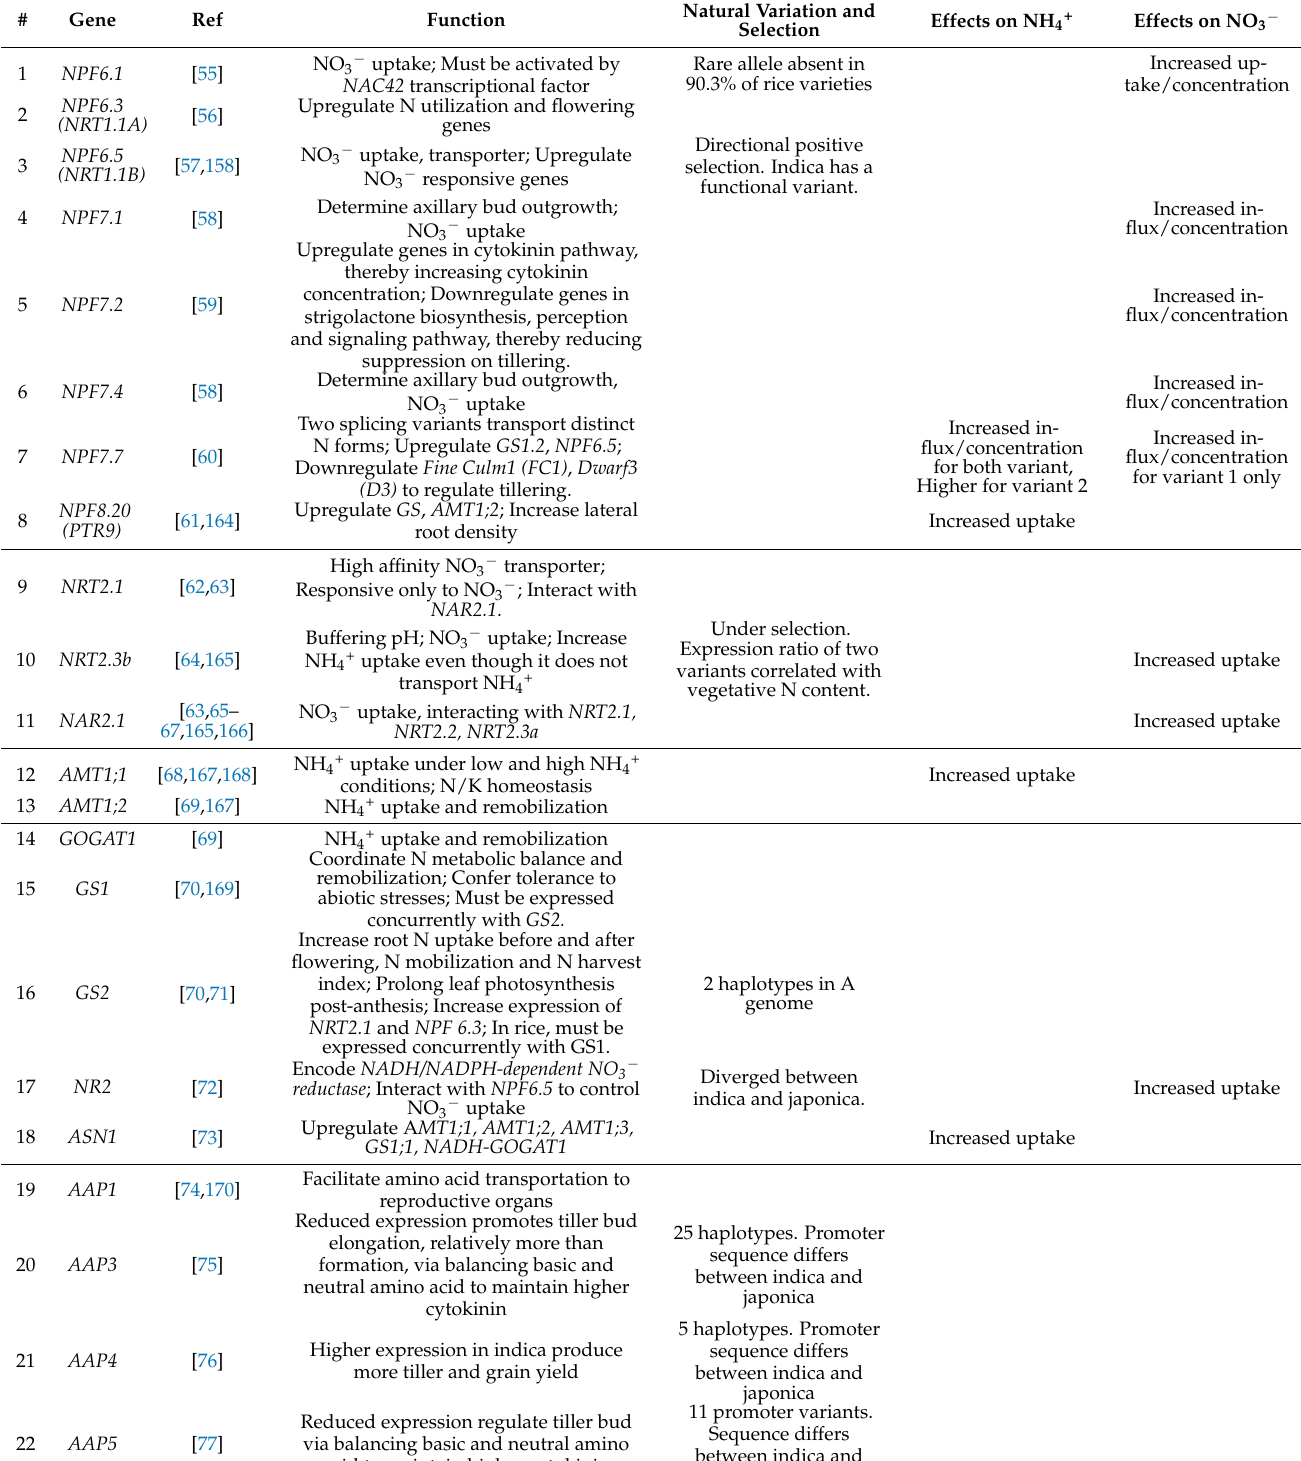
Table 3. Functions, selection, and effects on nitrogen acquisition of nitrogen metabolism genes in rice and wheat that were proven successful in improving yield. Empty cells indicate the lack of